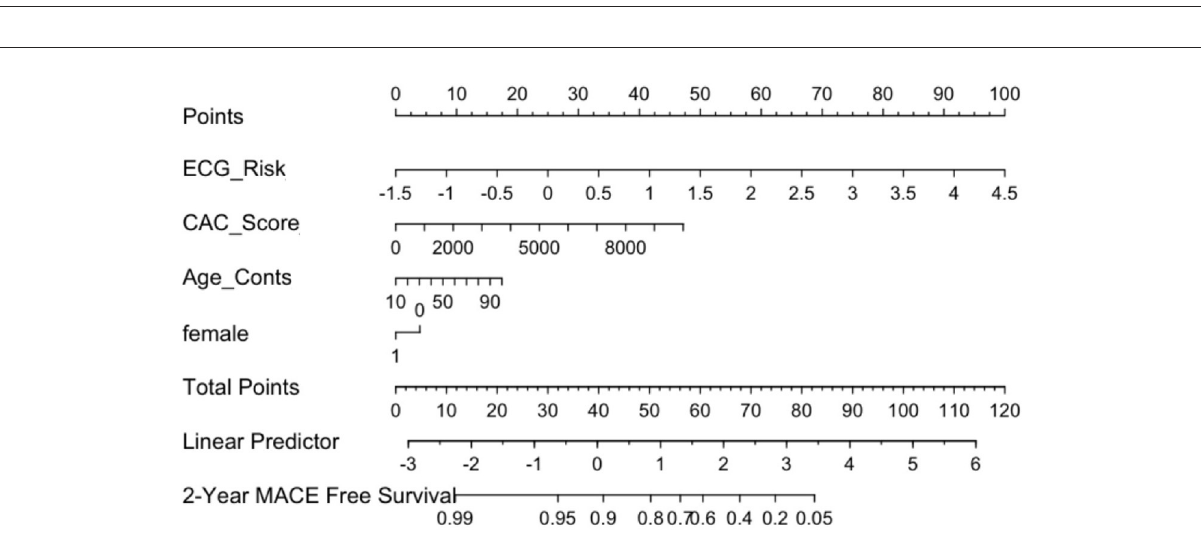
FIGURE8 ECG Nomogram (M nom ) demonstrates relative contribution of each covariate in MACE prediction. ECG risk score has the most significant contribution, followed by CAC score and other clinical